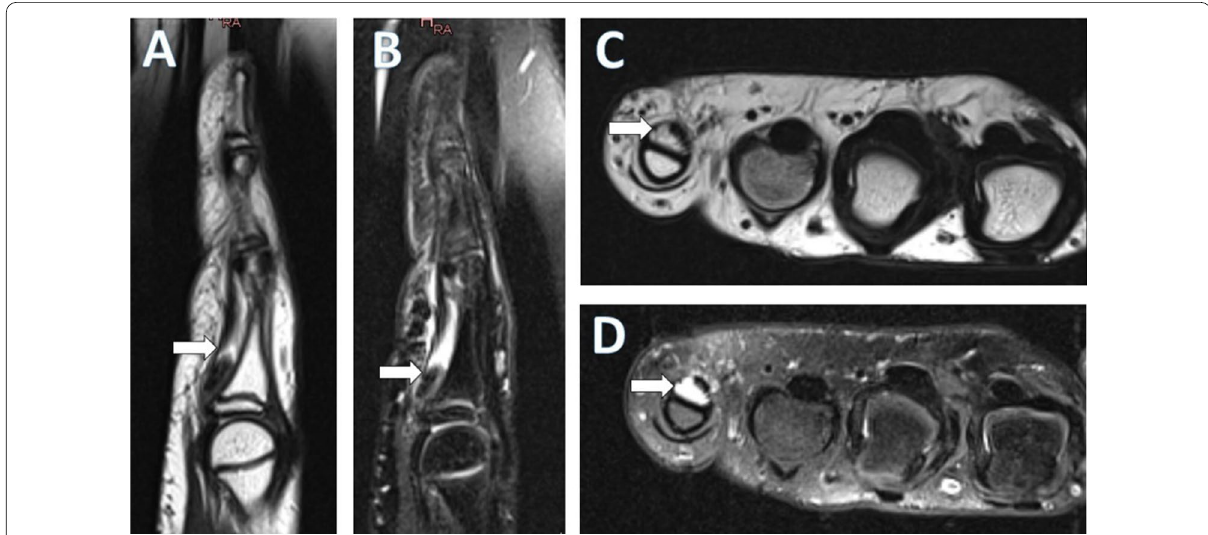
Fig. 2 Male patient 11 years old, complaining of post-traumatic right little finger pain and limitation of flexion. Sagittal T2WI ( a ), sagittal fat-saturated T2WI ( b ), axial T2WI ( c ), and axial PD fat saturated ( d ) weighted imaging of the right little finger showing complete interruption of the fibers of the flexor digitorum profundus of the right little finger at the level of the proximal phalanx (white arrow) with retraction and fluid filled gap distally. Diagnosis was complete tear of the flexor digitorum tendon of the right little finger with tendon